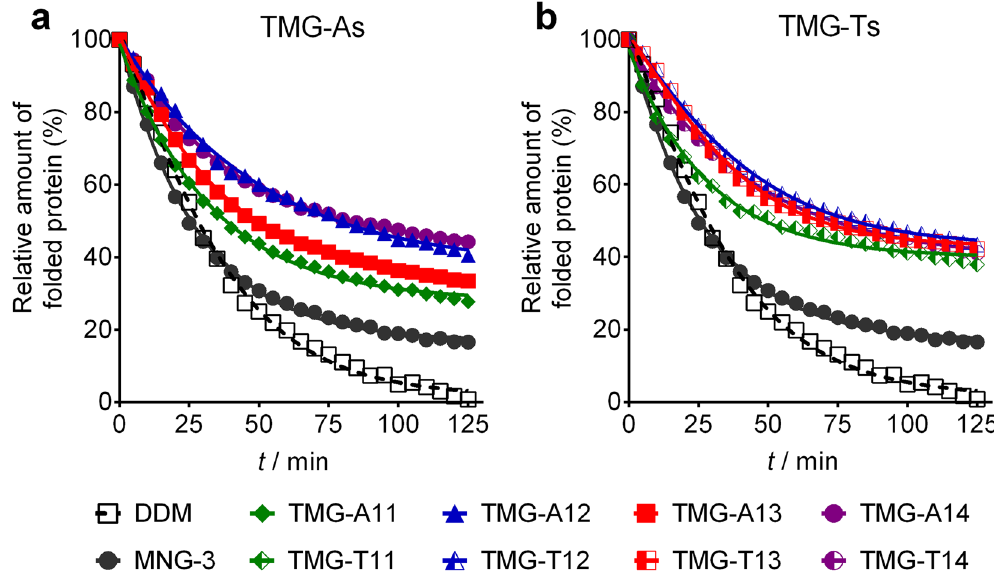
Figure 3. Thermal denaturation profile of UapA solubilized in individual agents (TMG-As ( a ) and TMG-Ts ( b ), MNG-3, or DDM) used at CMC + 0.04 wt%. The relative amounts of the folded transporter were monitored using CPM assay carried out at 40 °C for 125 min. Mean standard deviation ( n = 3) for DDM, TMG-A11, TMG- A12, TMG-A13, TMG-A14, MNG-3, TMG-T11, TMG-T12, TMG-T13 and TMG-T14 are 4.8, 5.2, 7.6, 3.4, 7.3, 5.1, 6.1, 4.6, 7.2, and 8.8,